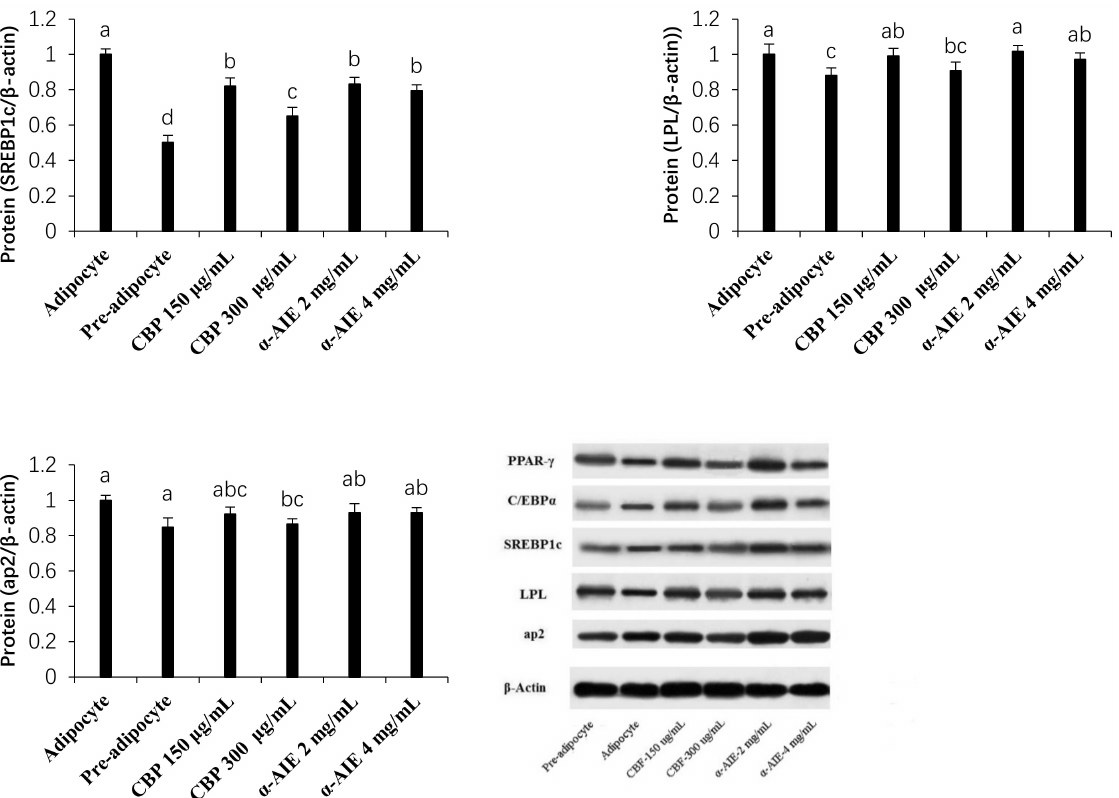
Figure 4. Effects of CBP and α -AIE on the protein expression level of PPAR γ , C/EBP α , SREBP1c, LPL, and ap2. The data were expressed as mean ± SD. Different letters mean significantly different ( p <